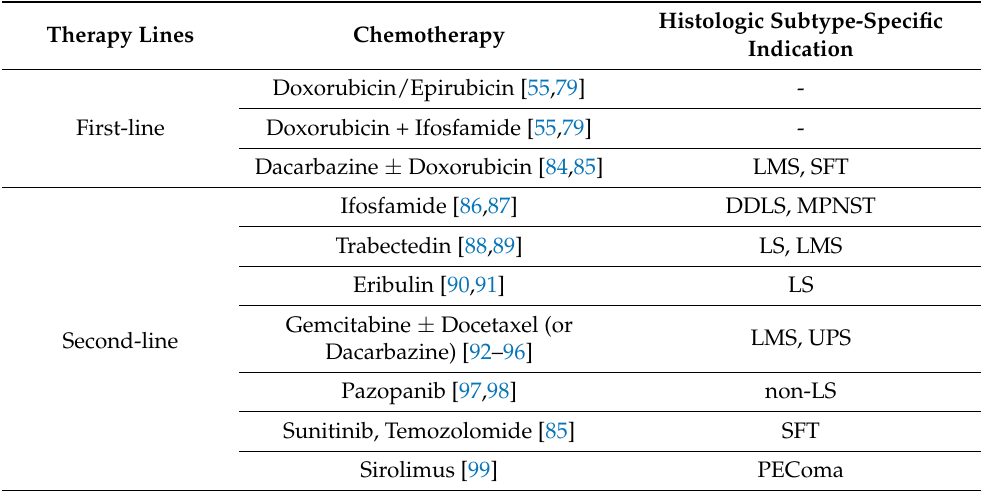
Table 4. Chemotherapy regimens for metastatic or irresectable retroperitoneal